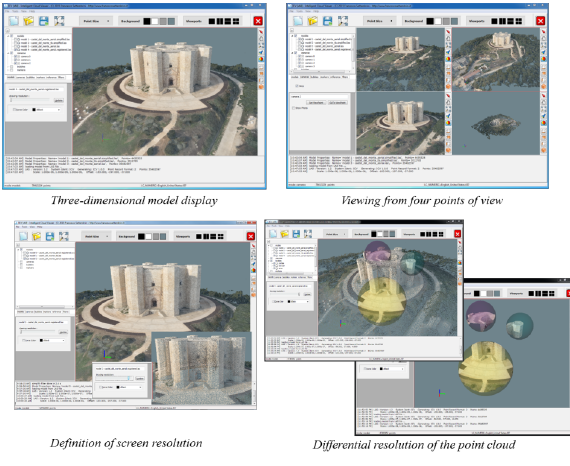
Figure 13 –Viewing point cloud management in